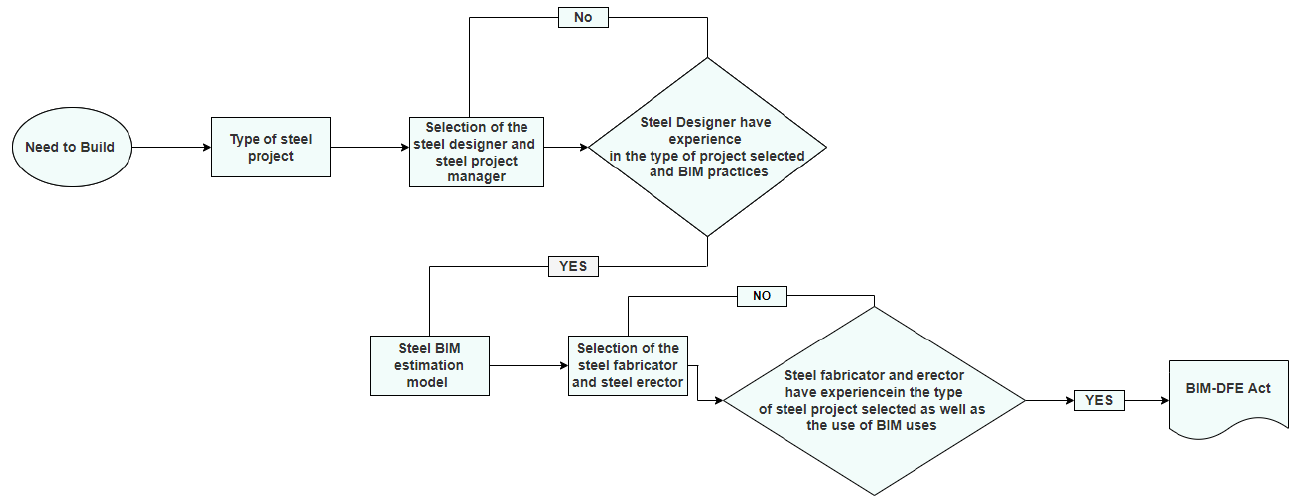
Figure 9. Steel BIM planning process.